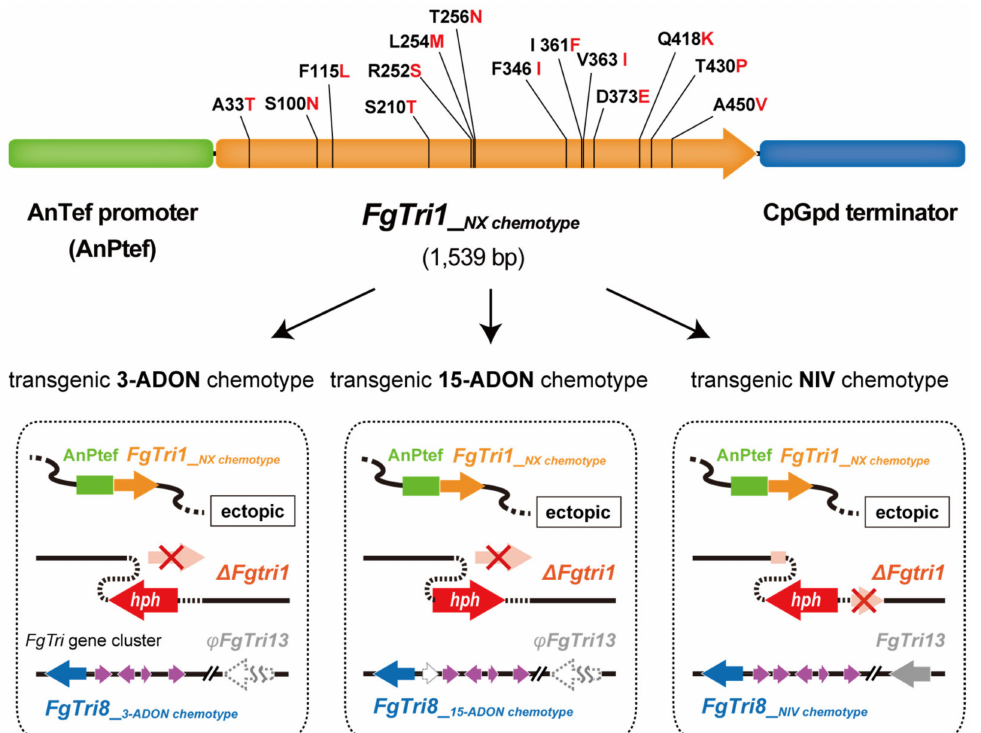
Figure 1. Generation of transgenic Fusarium strains expressing the C-7 hydroxylase gene, FgTri1_ NX chemotype , with different chemotypic backgrounds. The limited hydroxylation function at C-7 results strictly from 14 amino acid substitutions in the coding region of the evolved FgTri1_ NX chemotype . AnTef: Aspergillus nidulans translation elongation factor; CpGpd: Cryphonectria parasitica glyceraldehyde 3-phosphate dehydrogenase